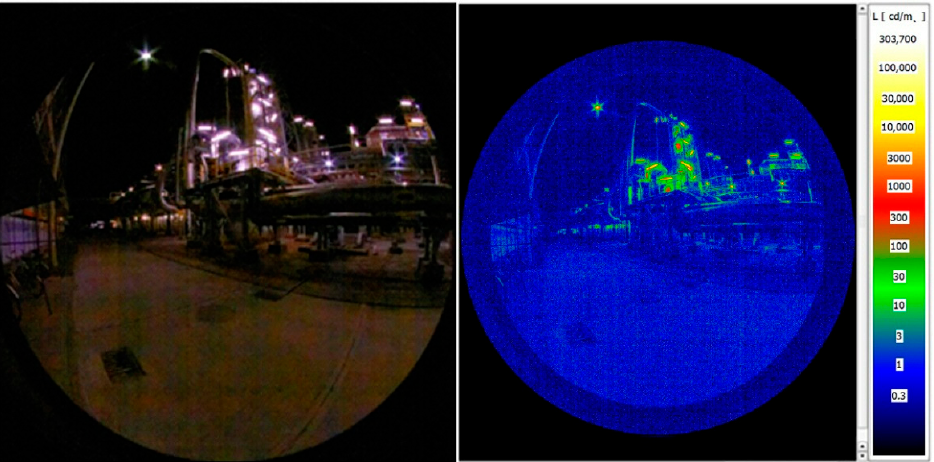
Figure 1. The view from the measurement point with corresponding luminance map. Measured glare rating (GR) = 32, subjective sensation of glare: noticeable, task of activity [5]: Regular vehicle traffic (max. 40 km/h), GR MAX from standard [5] = 45.